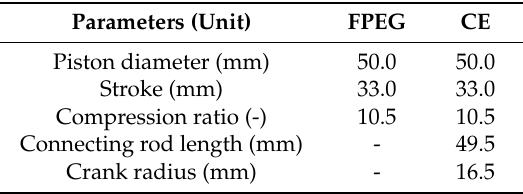
Table 1. Specifications of FPEG and CE.